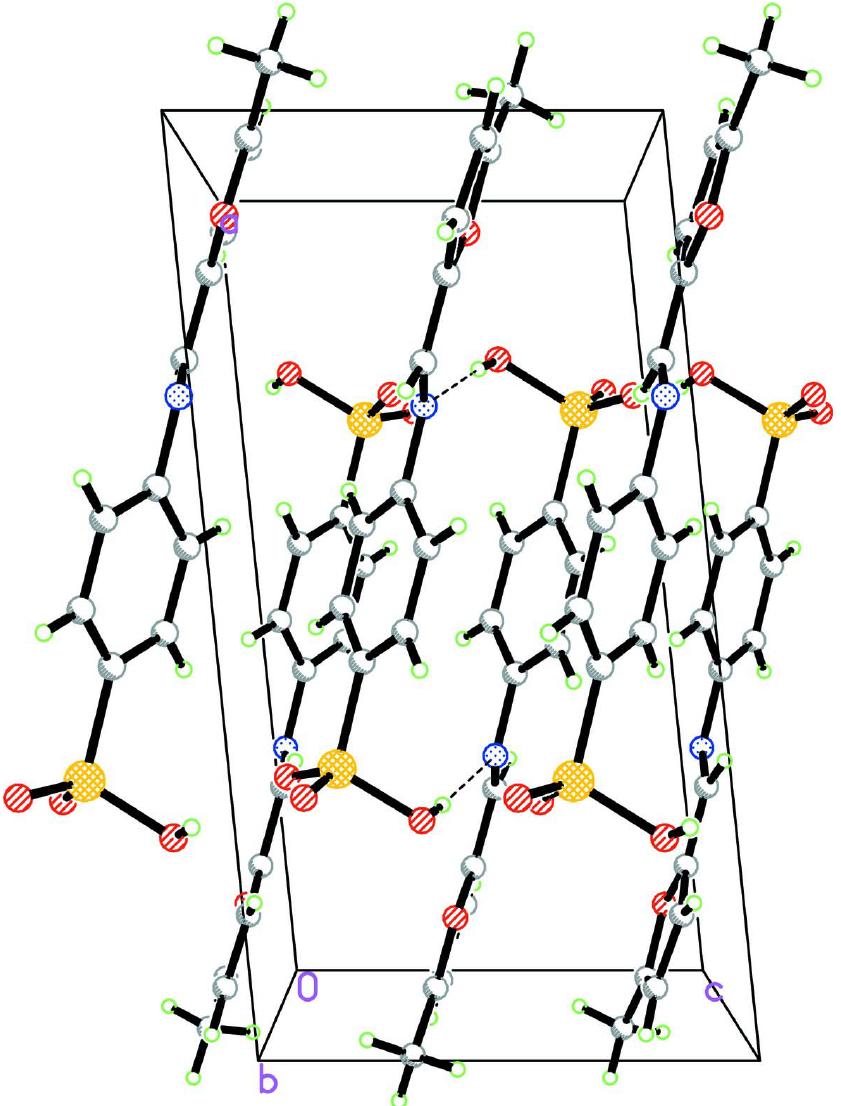
The molecular packing of (I) viewed along the b axis. The dotted lines represent hydrogen bonds. [Symmetry code: (A)- x + 1, y , - z + 1] ( E )-4-[(5-Methyl-2-furyl)methyleneamino]benzenesulfonic